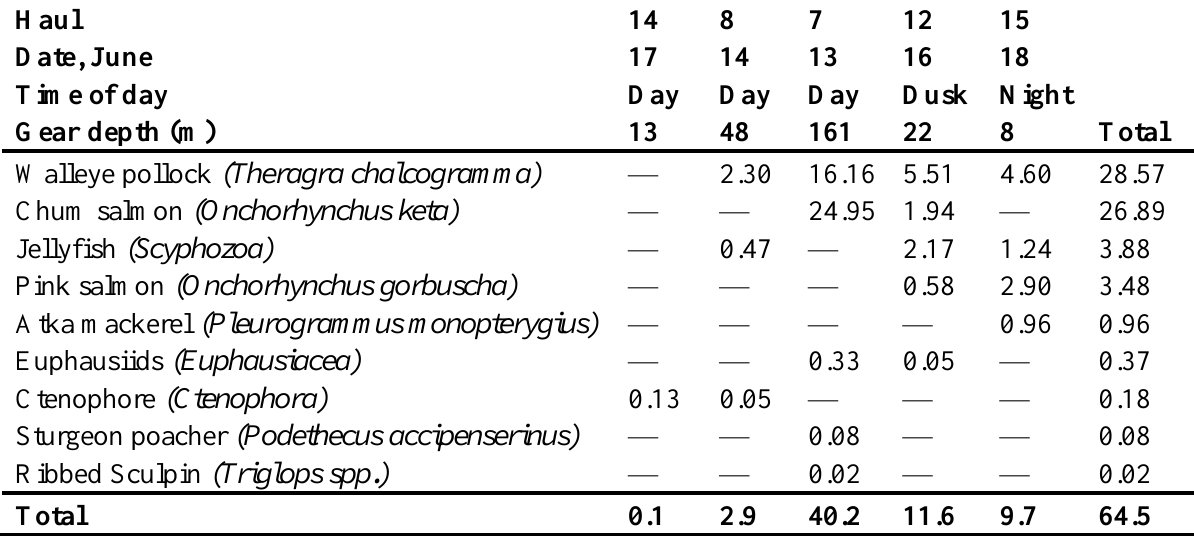
Table S3. Midwater trawl catch (kg) per tow (standardized to a 30 minute duration) for hauls within the hot spot area identified from the aircraft on 13 (haul 7), 14 (haul 8), 16 (haul 12), 17 (haul 14), and 18 (haul 15) June. One haul occurred within a hot spot while also observed from the aircraft (haul